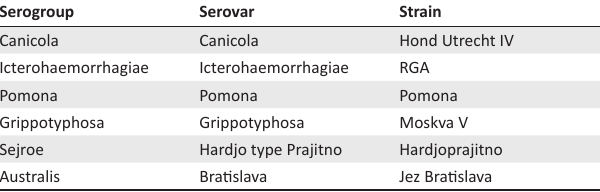
TABLE 1: Reference rabbit leptospiral antisera used for characterisation of leptospiral isolates from wildlife. Serogroup